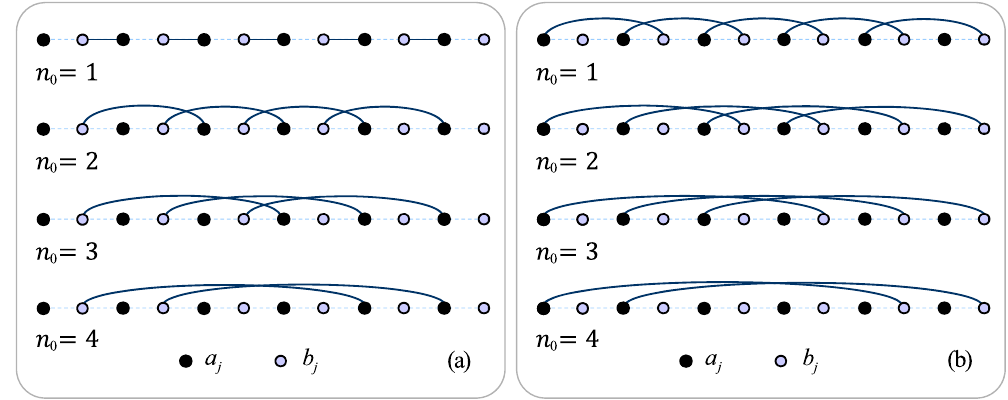
Figure 2. The structures of Majorana lattices for h defined in Eq. (60) with n 0 = 1, 2, 3, 4. We find that h n 0 contains 2 n 0 isolated sites, allowing the existence of zero modes. The isolated sites appear every other sites. But in fig ( a ), the isolated sites appear starting from the outermost sites; in fig ( b ), the isolated sites appear starting from the secondary outermost sites.